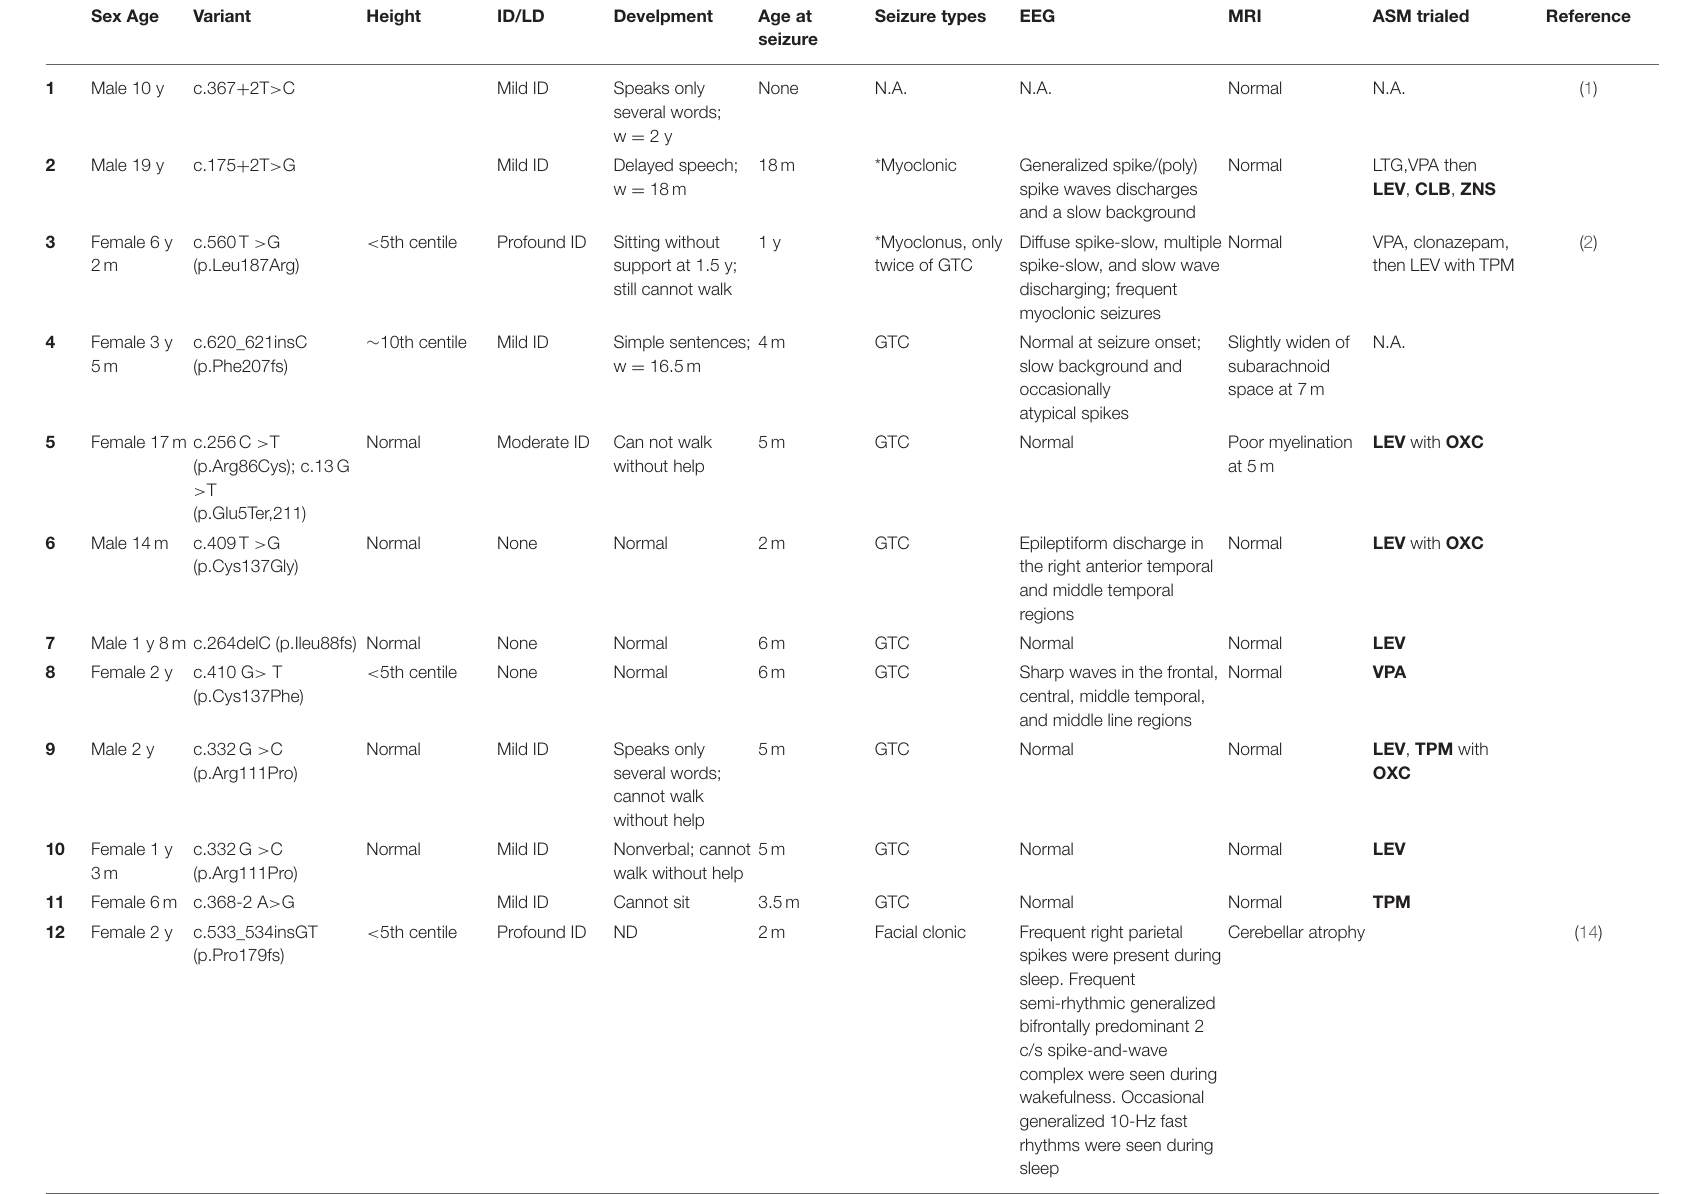
TABLE 1 | Genotype and phenotype details for individuals with CSNK2B